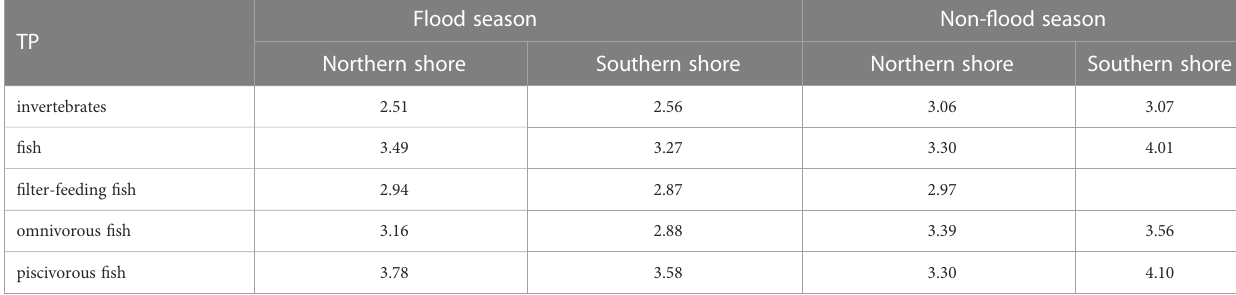
TABLE 2 Mean trophic positions of functional feeding